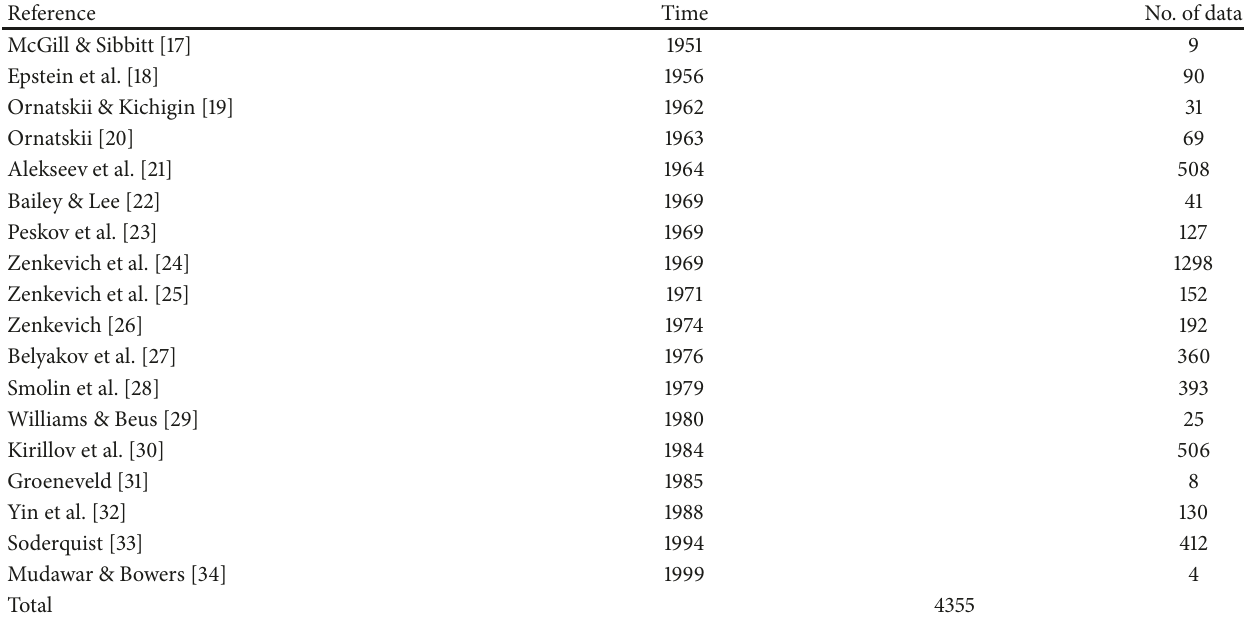
Table 1: CHF experiment database under high pressure